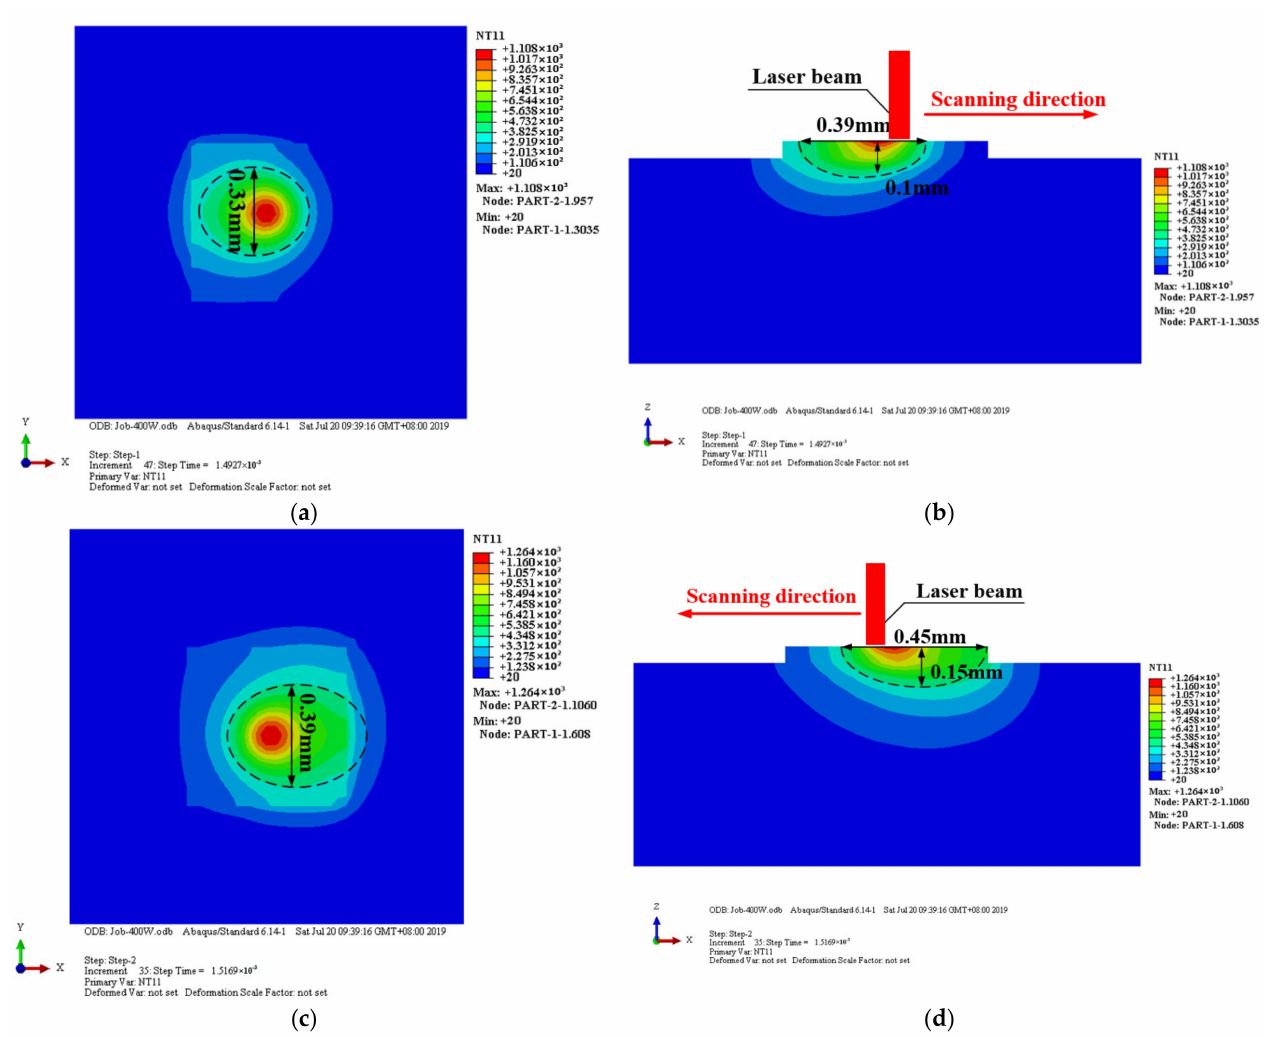
Figure 3. Temperature distribution at laser power P = 200 W, scanning speed v = 200 mm/s. ( a ) Surface temperature distribution at the first scanning midpoint. ( b ) Cross-section temperature distribution at the first scanning midpoint. ( c ) Surface temperature distribution at the second scanning midpoint. ( d ) Cross-section temperature distribution at the second scanning